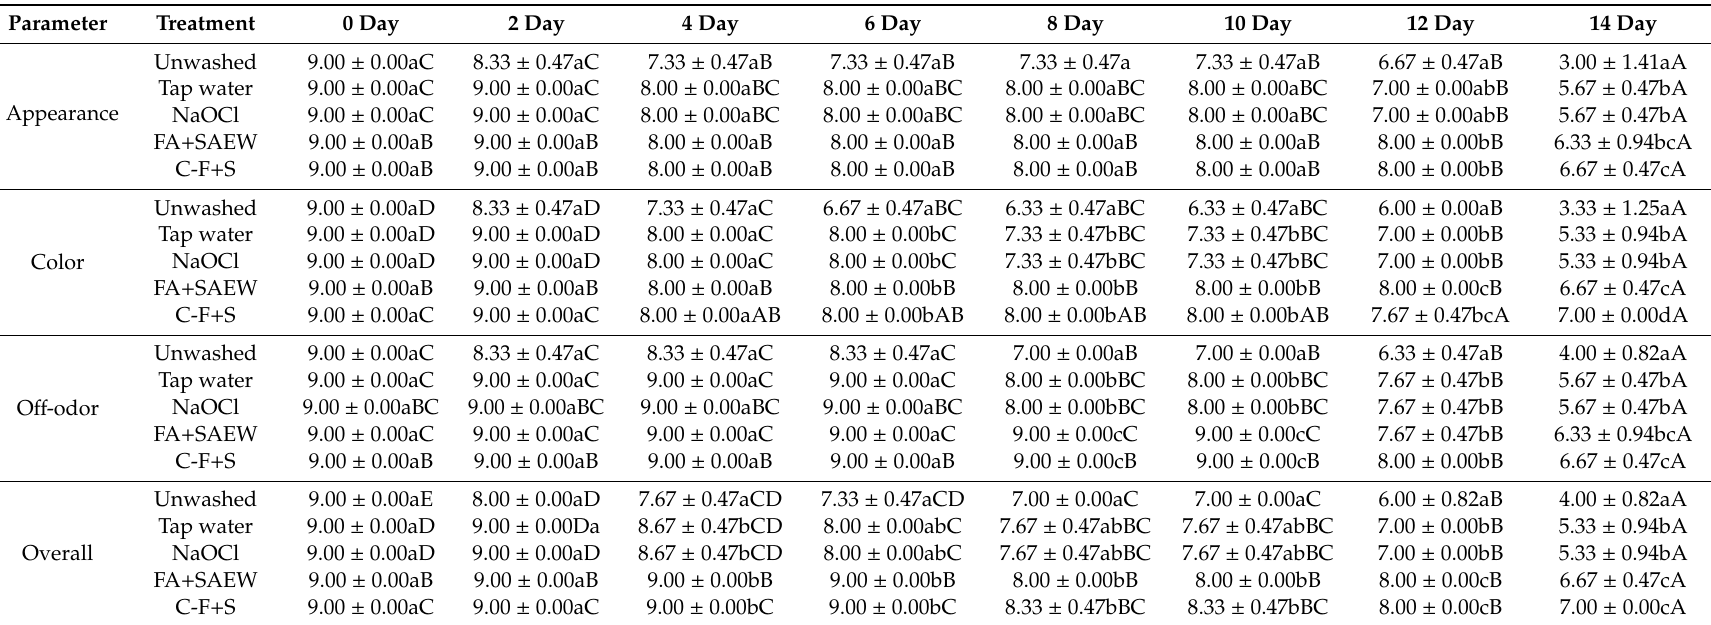
Table 3. Sensory quality changes of fresh tomato during storage at 4 ◦